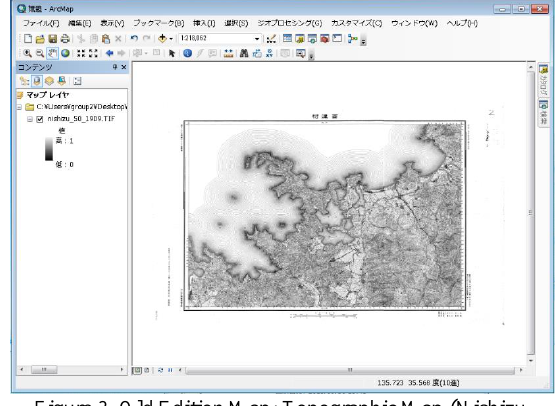
Figure 3. Old Edition Map: Topographic Map (Nishizu,